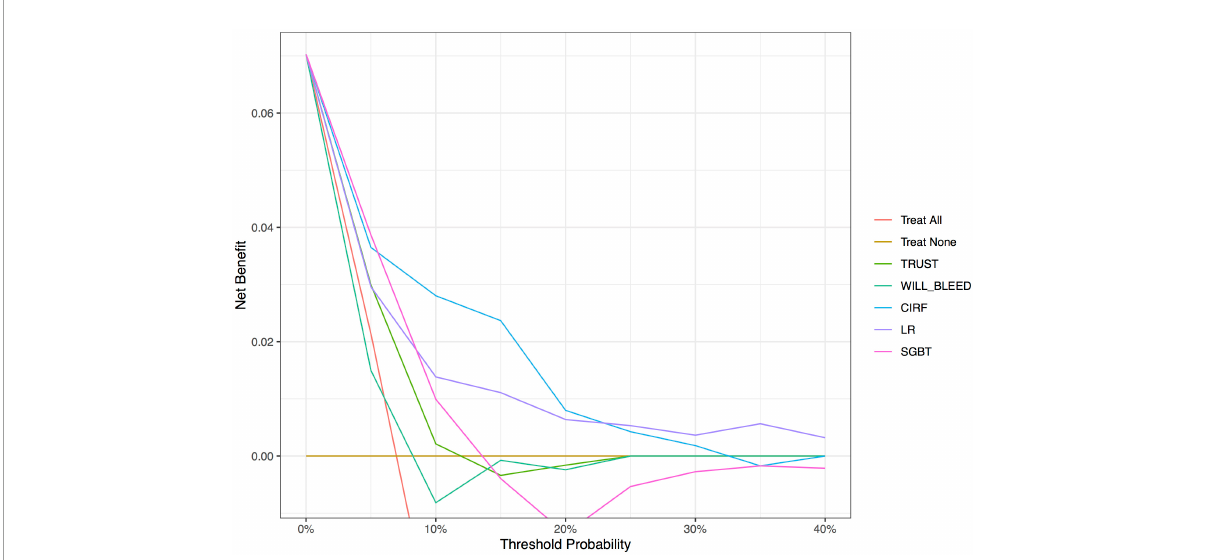
FIGURE2 Decision curve analysis of the conventional models and machine learning-based models. The X -axis indicates the threshold probability and Y -axis indicates the net benefit. The red solid line indicates the net benefit of all patients developing postoperative major bleeding events. Ochre’s solid line indicates the net benefit of no patients developing postoperative major bleeding events. LR, logistic regression; CIRF, conditional inference random forest; SGBT, stochastic gradient